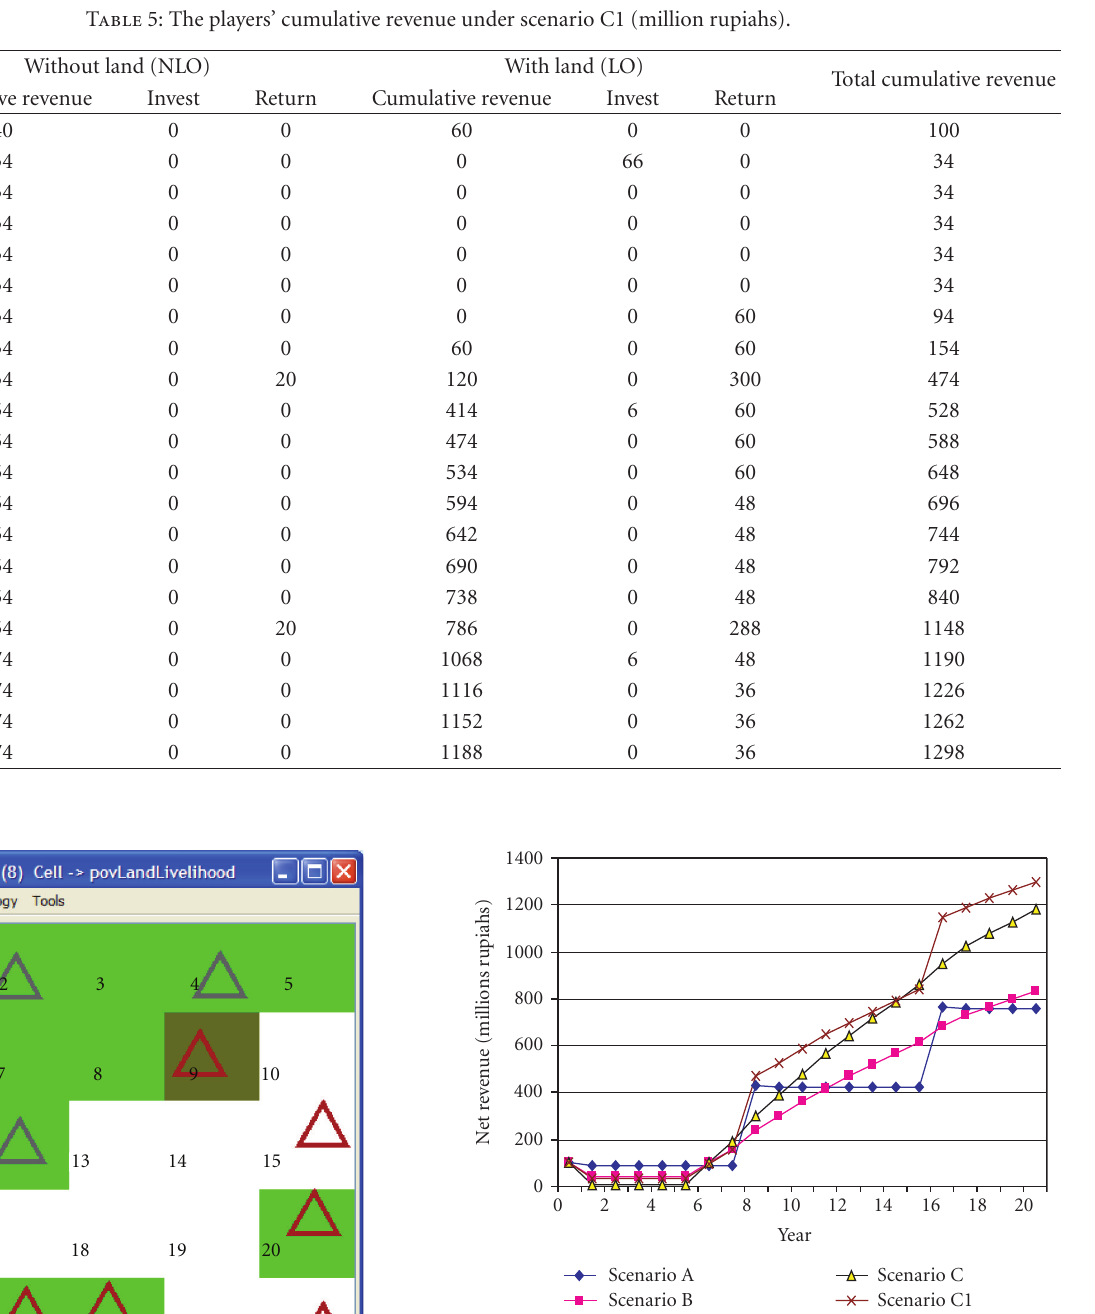
Figure 8: The total net revenue collected by 10 players during 20 years (in million rupiahs) for Scenario A, B, C and C1. values early in the rotation. Scenario B has a higher NPV value than scenario A at lower interest rates (e.g.,